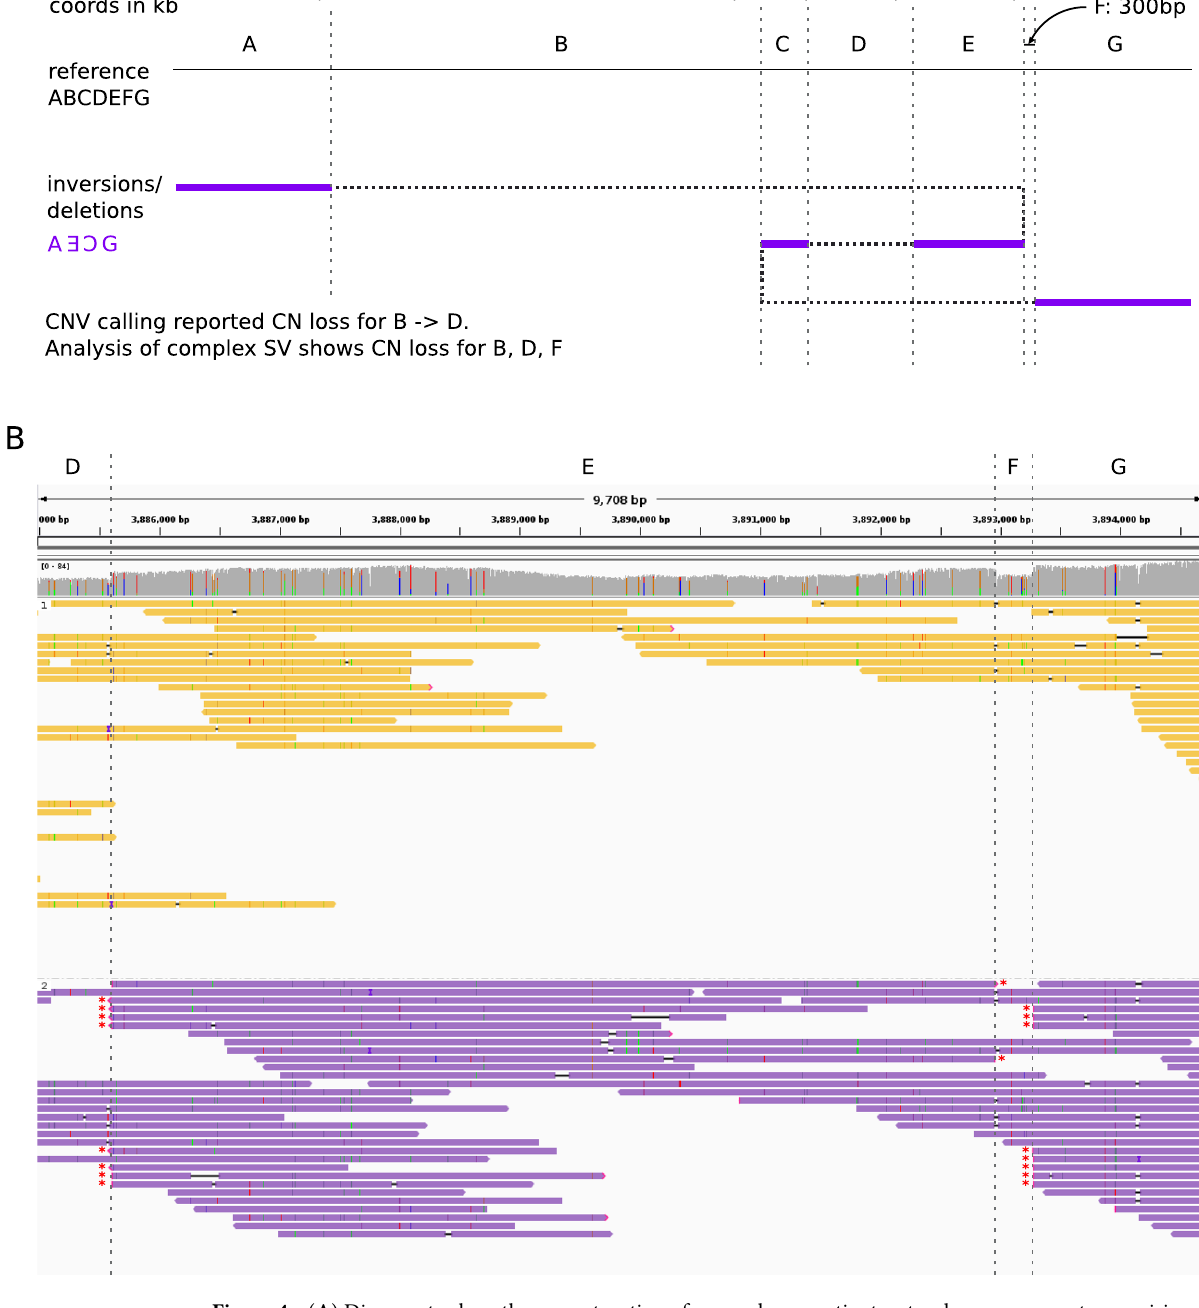
Figure 4. ( A ) Diagram to show the reconstruction of a complex somatic structural rearrangement comprising three deleted segments and two inverted segments. Top: arrangement of segments in the reference sequence, and coordinates of SV breakpoints given to the nearest kilobase. Breakpoints are indicated by vertical dashed lines. Bottom: The rearranged haplotype is obtained by following the path of the dotted/purple line, with purple sections indicating the included segments. The inversion breakpoints between segments A–E and segments C–G both span over 10 kb and were reported by both Manta (short-read data) and Sniffles (long-read data). ( B ) Integrative Genomics Viewer screenshot showing Nanopore reads for the tumour sample, grouped and coloured by haplotype as determined by WhatsHap. Again, vertical dashed lines indicate the position of breakpoints and segments are labelled with letters as in ( A ). Split ends supporting the breakpoints are indicated with a red asterisk. All reads supporting all 3 breakpoints are assigned to the lower (purple) haplotype, confirming all breakpoints in ( A ) as in cis. Note that it would not have been possible to confidently phase these breakpoints from the short-read data alone. The nearest heterozygous SNVs to section F are at 3,887,048 and 3,895,908. This means it is not possible to say whether the breakpoints at A|E and E|C are in phase, nor whether A|E and C|G are in